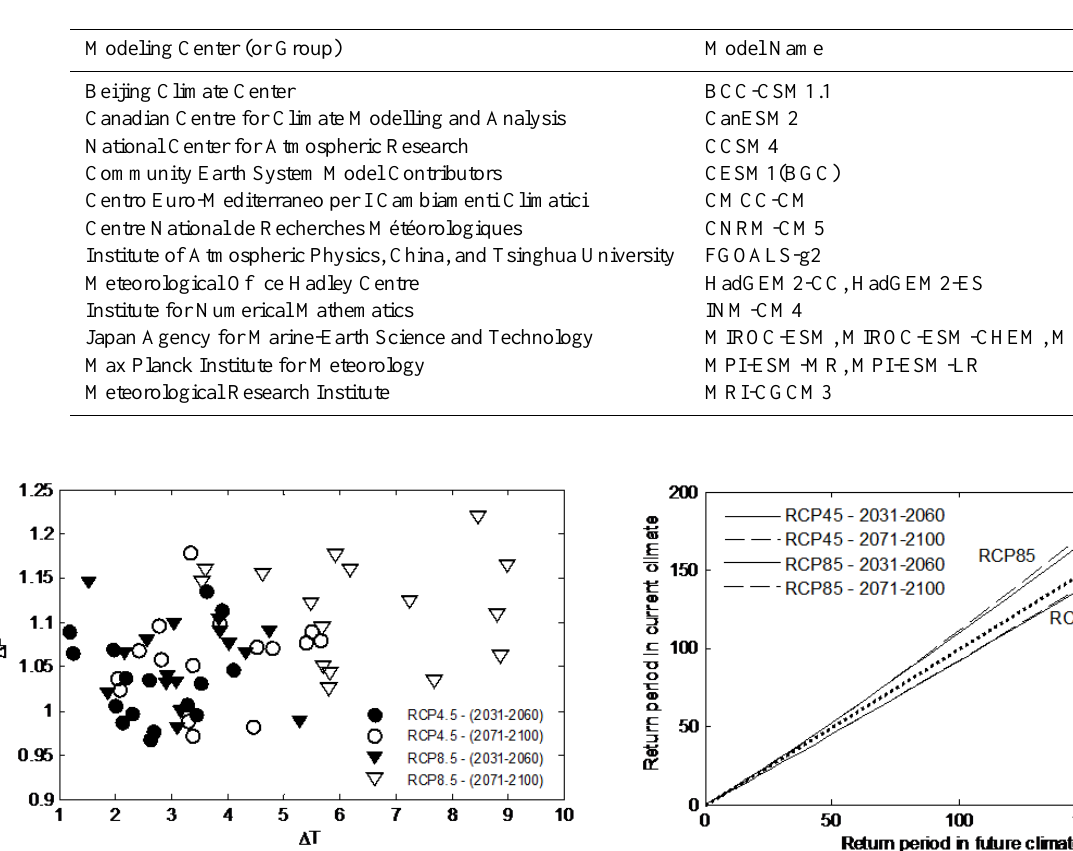
Table 2. Global climate models from the CMIP5 ensemble used in the study.